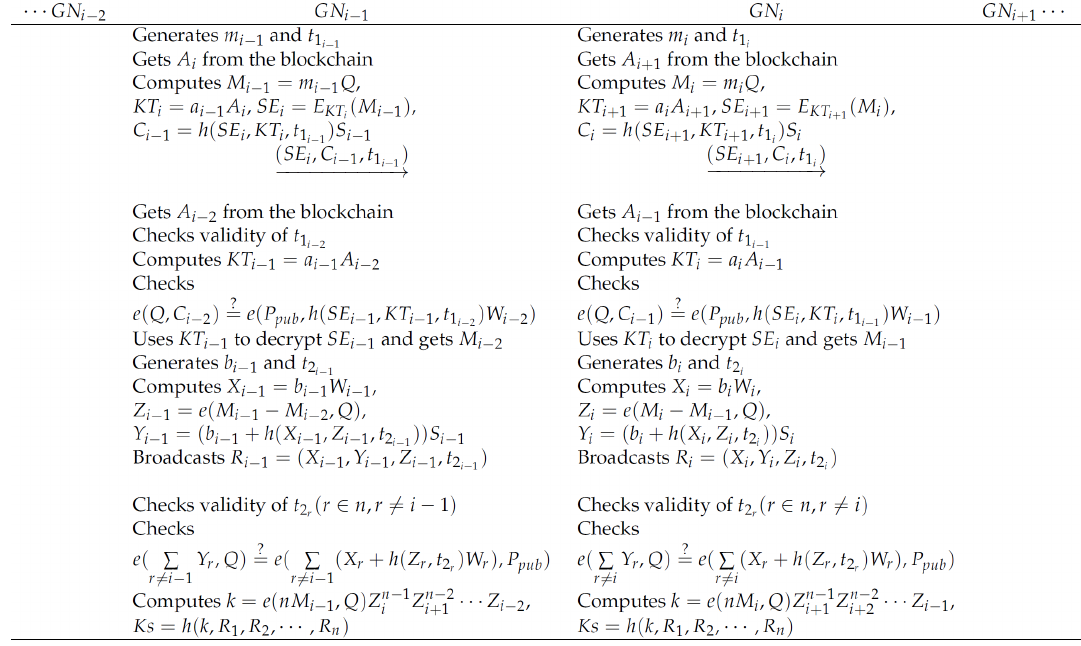
Figure 3. The mutual authentication phase and the group key generation phase of our